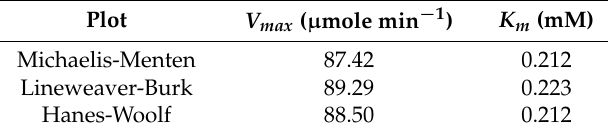
Table 5. Summary of K m and V max determined from three.